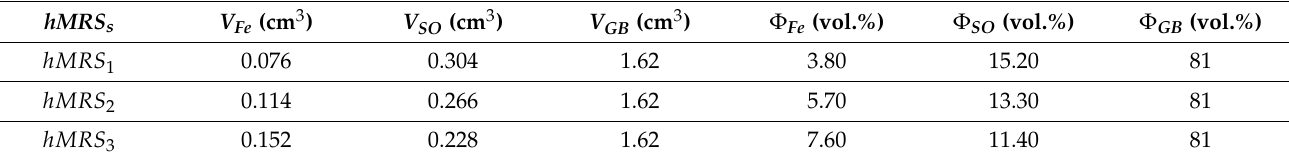
Table 2 shows the Fe microparticle volume ( 𝑉 (cid:3007)(cid:3032) ), SO volume ( 𝑉 (cid:3020)(cid:3016) ), and GB fabric volume ( 𝑉 (cid:3008)(cid:3003) ) of each hMRS sample. Using these volumes and taking into account the vol- ume of MRSs ( 0.38 cm (cid:2871) ) absorbed in the GB textile and the data from Table 1, we calcu-